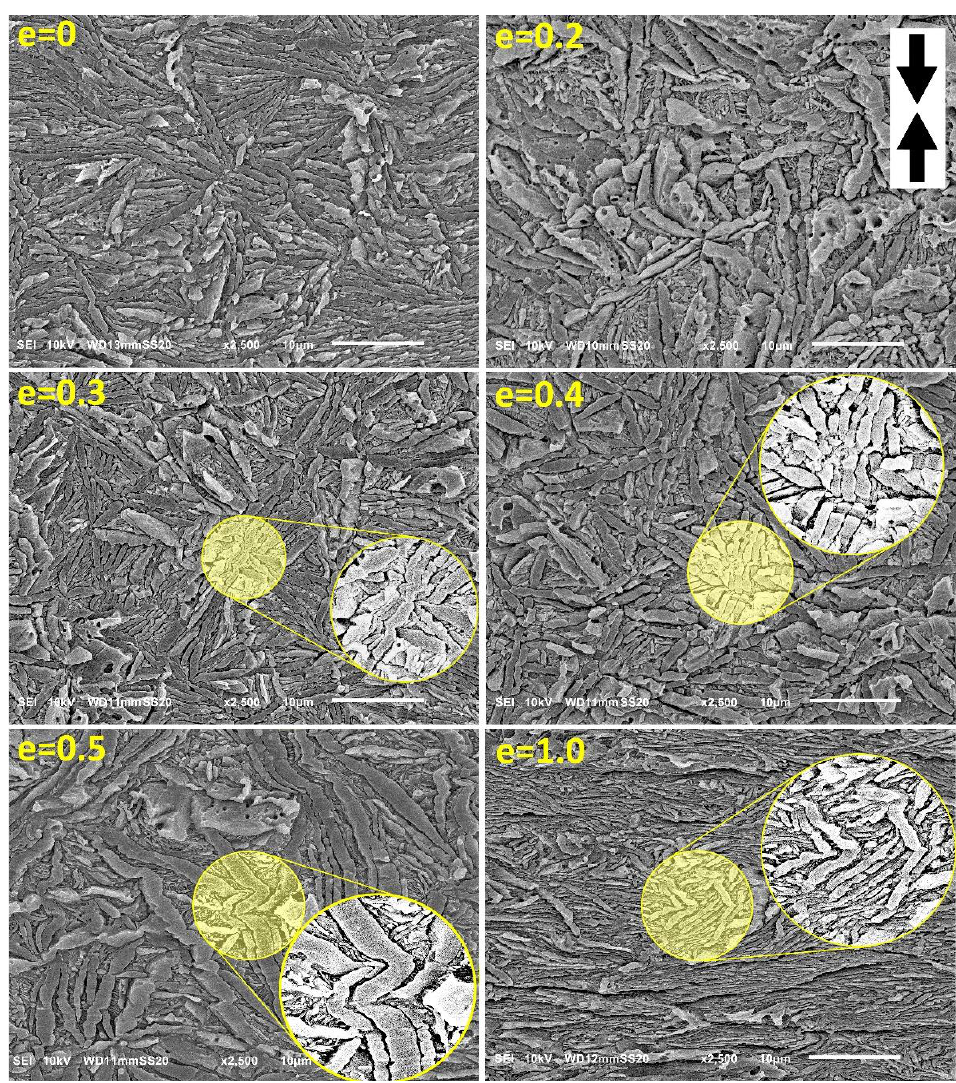
Figure 6. SEM micrographs of the H4-CE samples deformed by uniaxial compression to the true strain indicated. The direction of compression is vertical. Circular insets show enlarged details.